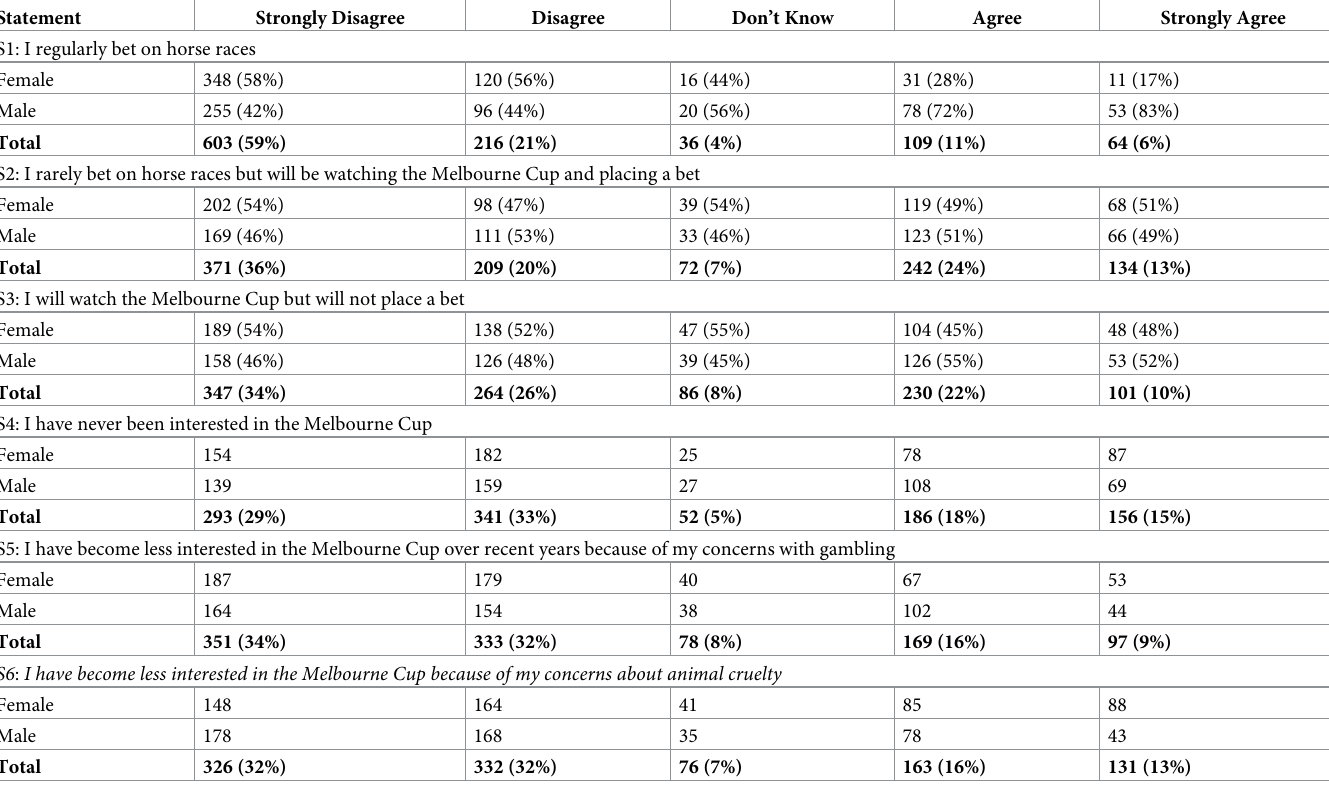
Table 1. Ordinal agreement among 1028 respondents with six statements regarding the Melbourne Cup and horse-racing stratified by